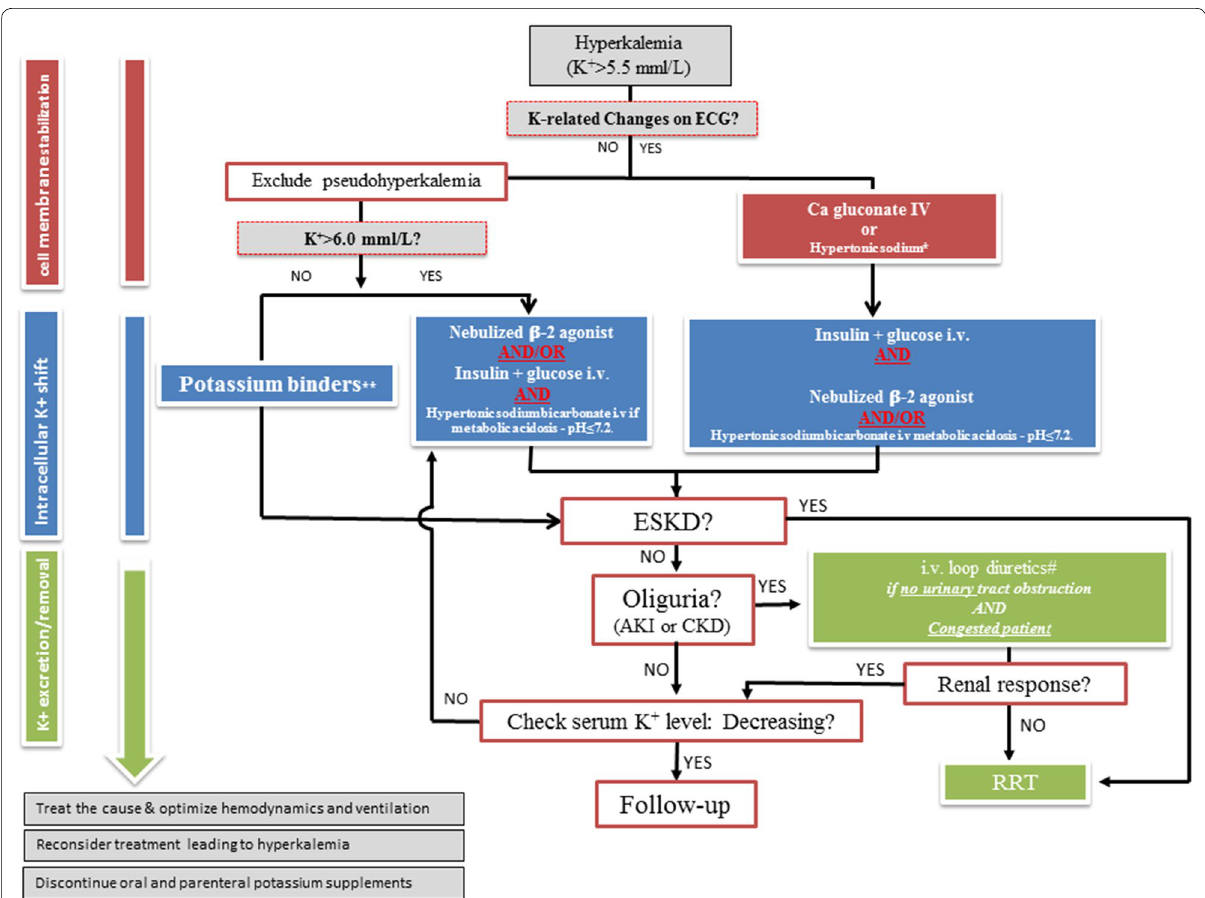
Fig. 1 Suggested algorithm for hyperkalemia treatment in the acutely ill. *In case of Digitalis intoxication or hypercalcemia. **Sodium zirconium cyclosilicate and patiromer when available, kayexalate if not available. ESKD end-stage kidney disease, AKI acute kidney injury, CKD chronic kidney disease, RRT renal replacement